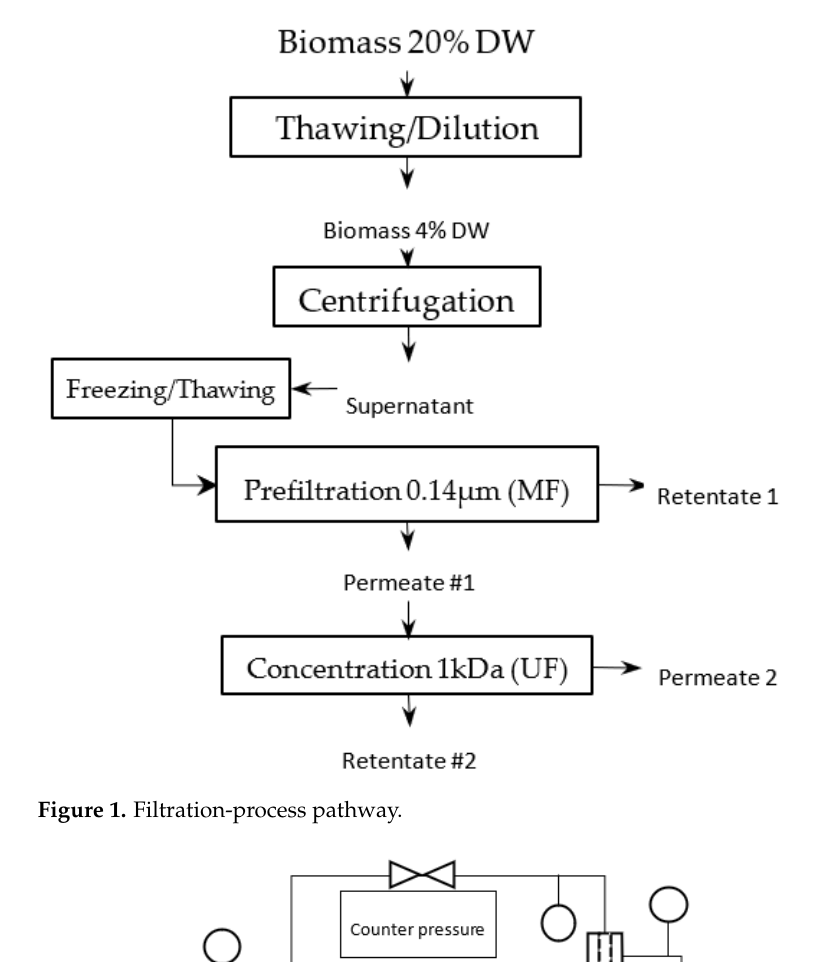
Figure 1. Filtration-process pathway.